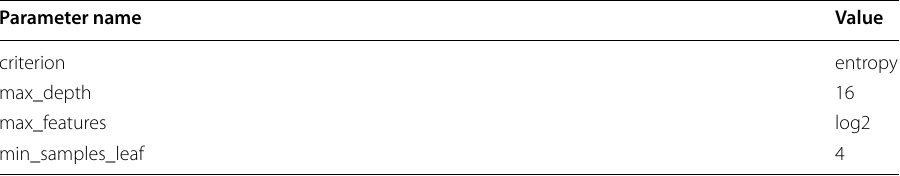
Table 76 Modes of DT tuned hyperparameter values for experiments with the data exfiltration dataset